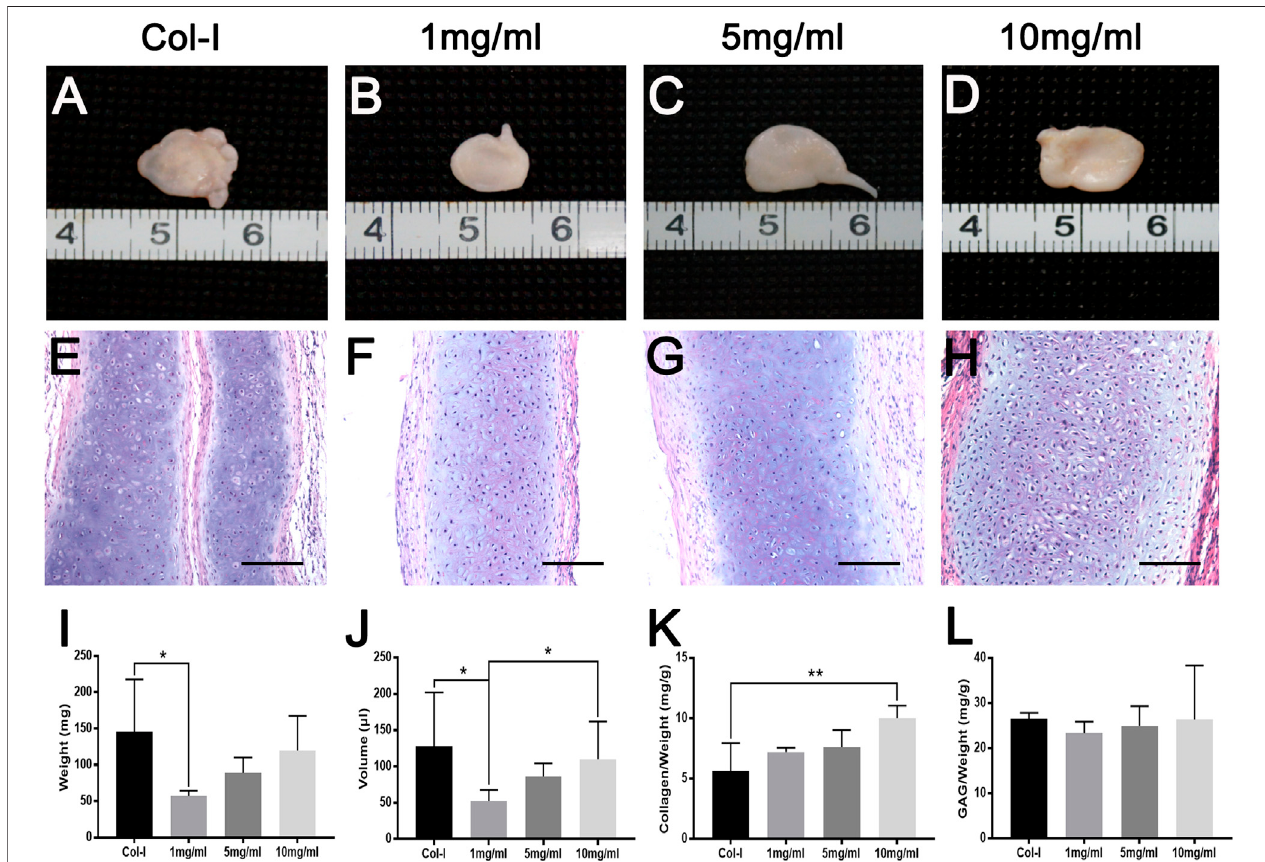
FIGURE 5 | Macroscopic appearance, HE staining and gross analyses of dcECM hydrogel grafts in vivo at 4 weeks after grafting. Grafts were harvested and comparedat4 weeksaftertransplantation. (A – H) MacroscopicappearanceandHEstainingofgraftsfromcollagenI(Col-I) (A,E) anddcECMhydrogelsat1 (B,F) ,5 (C, G) , and 10 (D, H) mg/ml. (I, J) Comparisons of weights (I) and volumes (J) of grafts after 4 weeks in vivo culture. (K, L) Collagen and GAG contents analyses of grafts after 4 weeks in vivo culture. Scale bars (cid:2) 100 µm. Error bars showed means ± SD, * p < 0.05, ** p < 0.01, n (cid:2) 5.